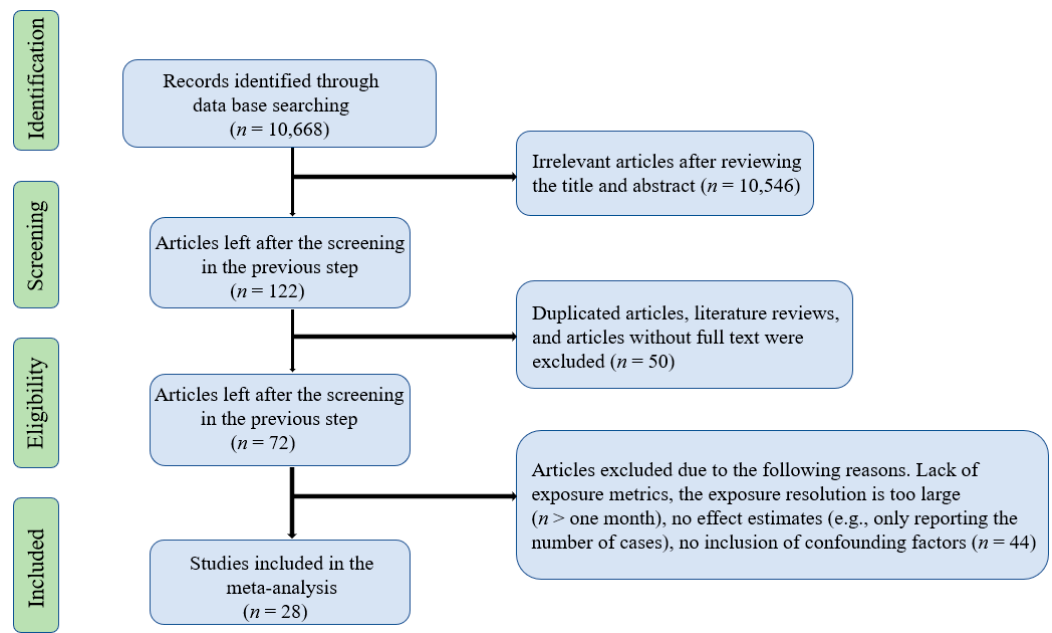
Figure 1. Flowchart showing the screening process for included articles.